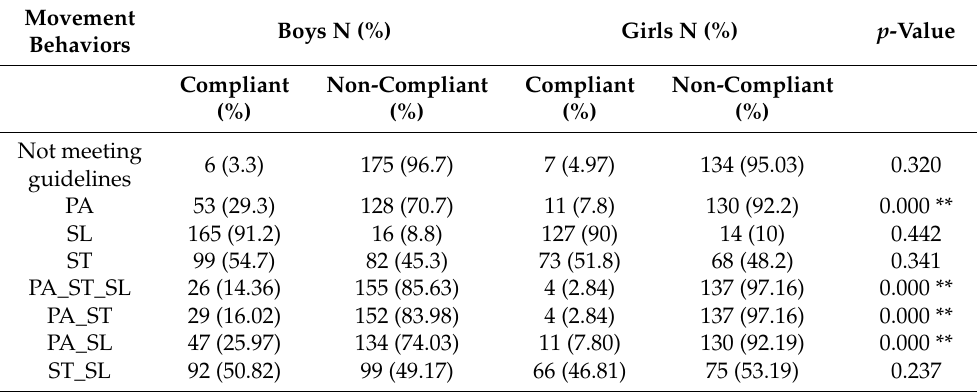
Table 3. Meeting of 24-Hour Movement Guidelines among preschoolers’ boys and girls.